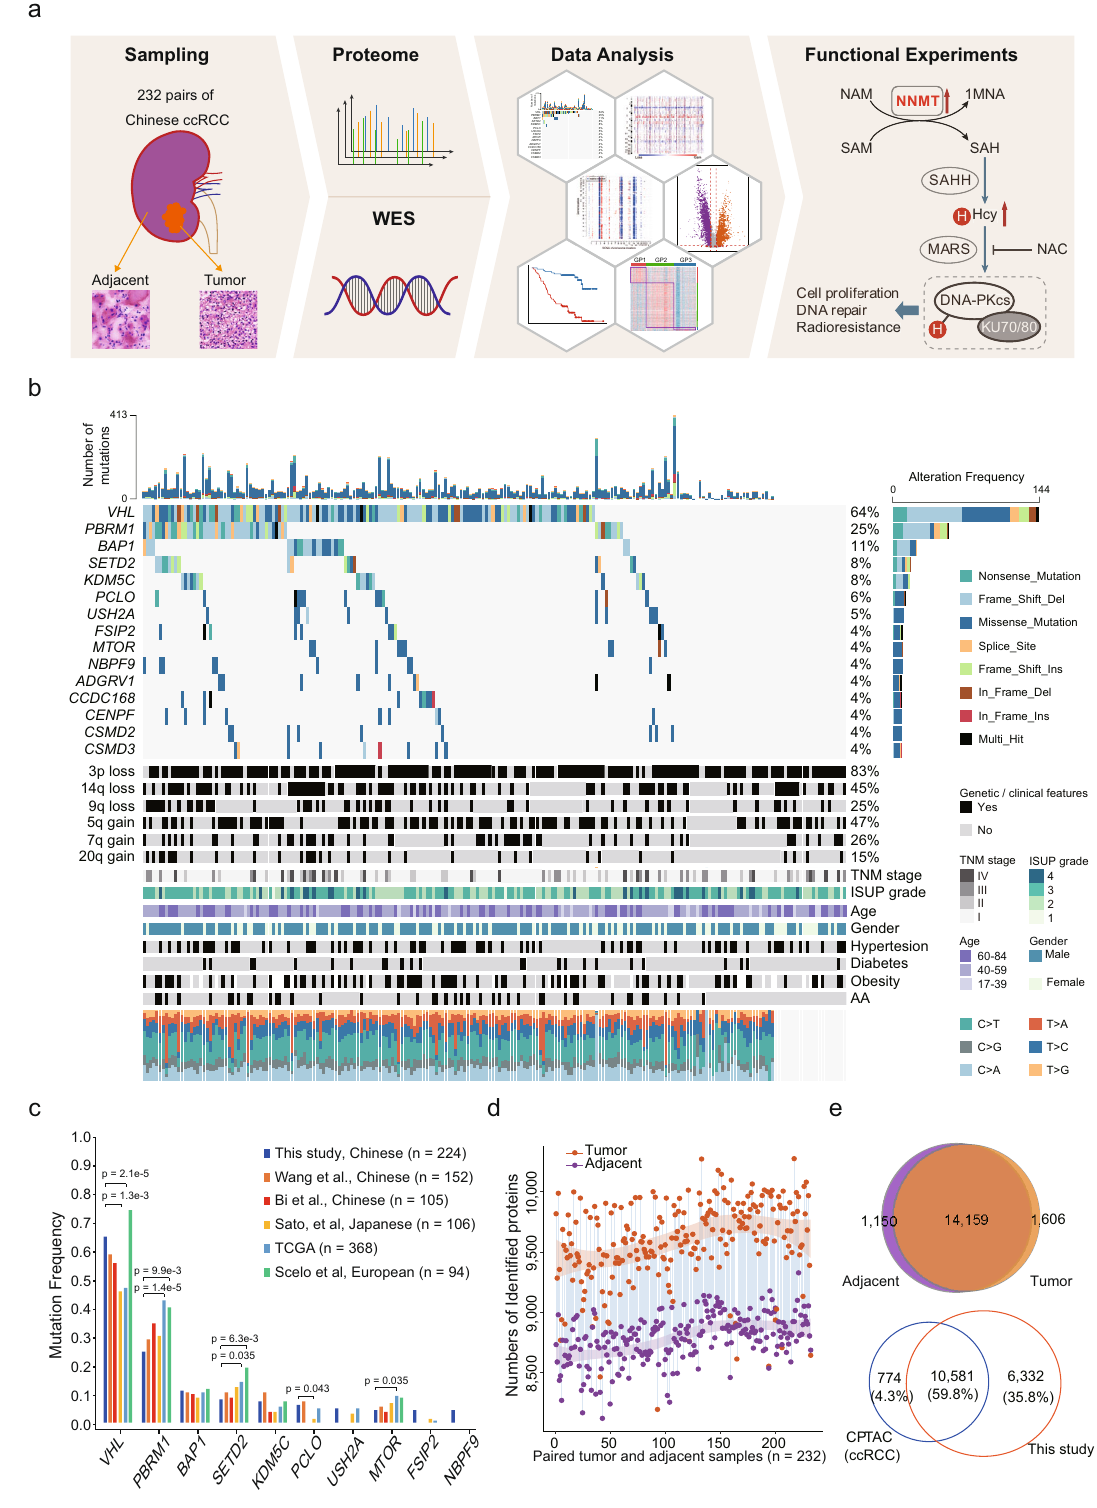
Fig. 1 Proteogenomic Landscape of Chinese ccRCC. a Schematic representation of the multiomics analyses of ccRCC, including sample preparation, protein identi fi cation, WES, and function veri fi cation. b Genomic pro fi le and associated clinical features of 224 ccRCC patients. c Comparison of frequently mutated genes among Chinese, Japanese, European, and TCGA cohorts. P values derived from two-sided Fisher ’ s exact test. d Overview of proteomic pro fi les of pairwise ccRCC samples. The dashed curves fi tted by lasso regression show the distribution of protein identi fi cations. The shading that underlies the lasso curves denotes the 95% con fi dence intervals. e The upper Venn diagram shows the overlap of proteins identi fi ed in tumors and adjacent normal tissues. The lower Venn diagram shows that proteins identi fi ed in this study cover most of the proteins identi fi ed in the CPTAC ccRCC